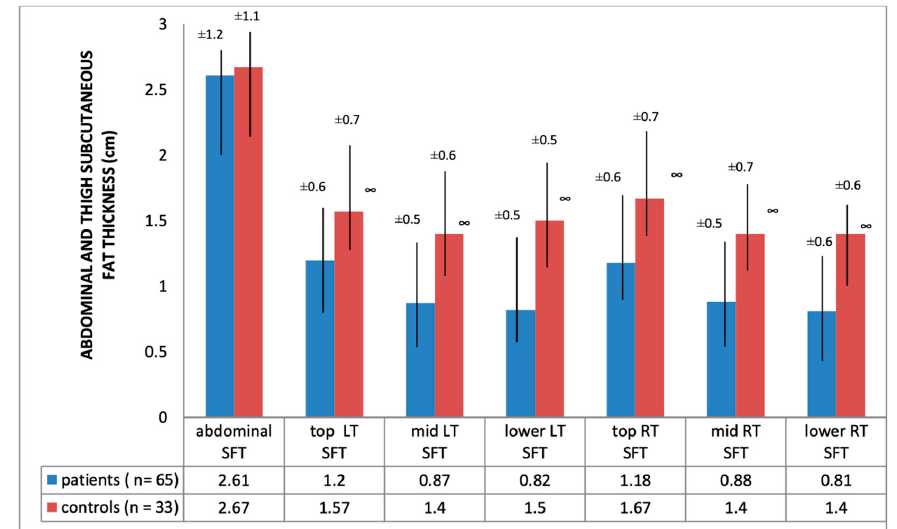
Figure 2. Abdominal/thigh subcutaneous fat thickness of hemodialysis patients and heathy subjects; ∞ significance = p < 0.01; SFT: subcutaneous fat tissue; LT: left thigh; RT: right thigh.